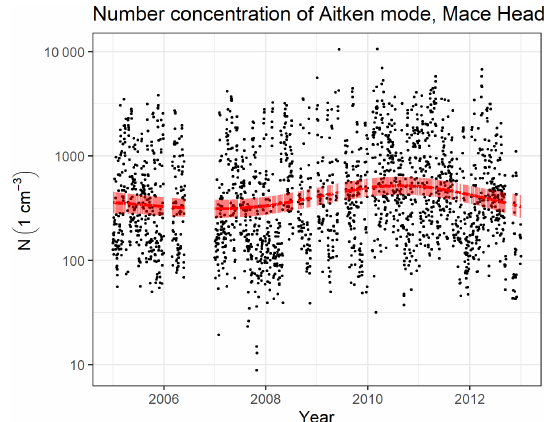
Figure 2. DLM fit for Mace Head Aitken mode number concentra- tion. Black dots represent daily averages of Aitken mode number concentrations at Mace Head. The solid red line represents the es- timated level, and the red ribbon represents the 95% confidence interval for the